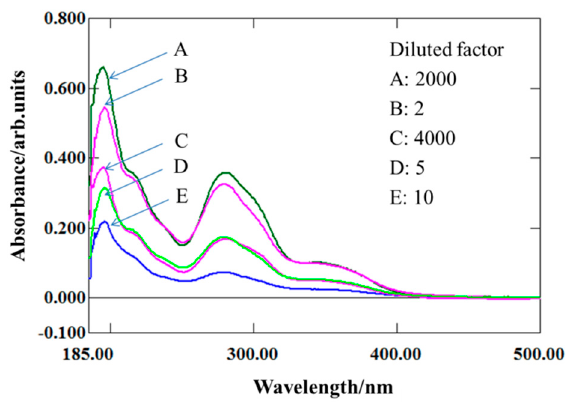
Figure 2. UV-VIS absorption spectra of different dilutions of saturated folic acid or saturated FA-2-DG solutions. ( A ) 2000-fold dilution of saturated FA-2-DG solution. ( B ) 2-fold dilution of saturated folic acid solution. ( C ) 4000-fold dilution of saturated FA-2-DG solution. ( D ) 5-fold dilution of saturated folic acid solution. ( E ) 10-fold dilution of saturated folic acid solution.